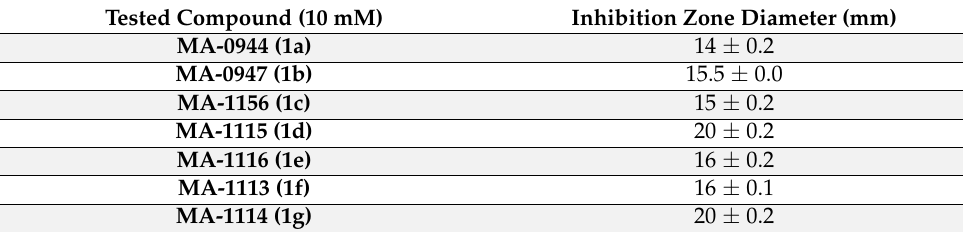
Table 2. Determination of the MIC, and MBC (µM) of the tested fluoroarylbichalcophene deriva- tives ( 1a – 1g ) against S. aureus .